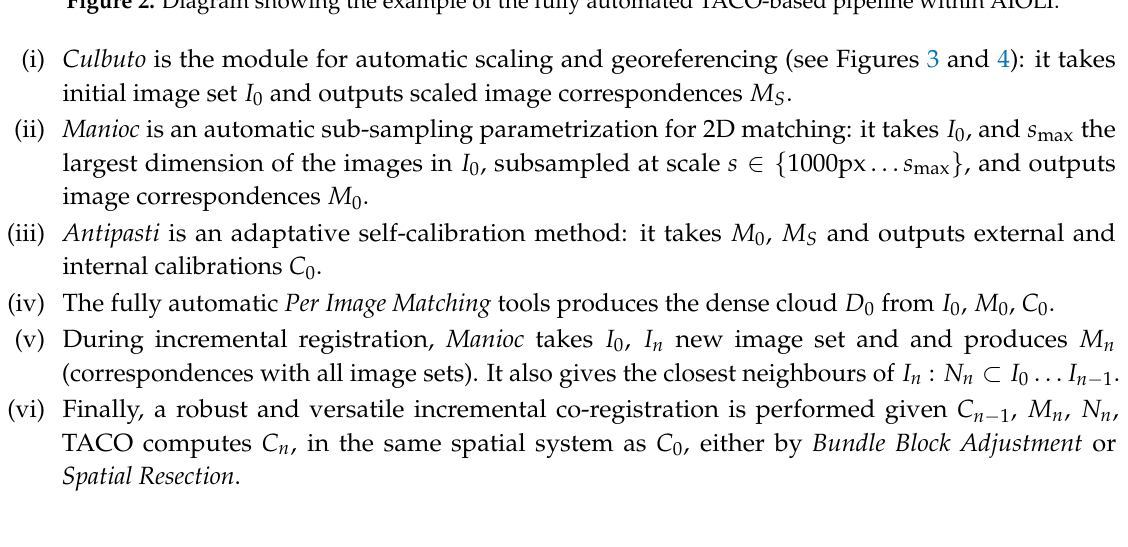
Figure 2. Diagram showing the example of the fully automated TACO-based pipeline within